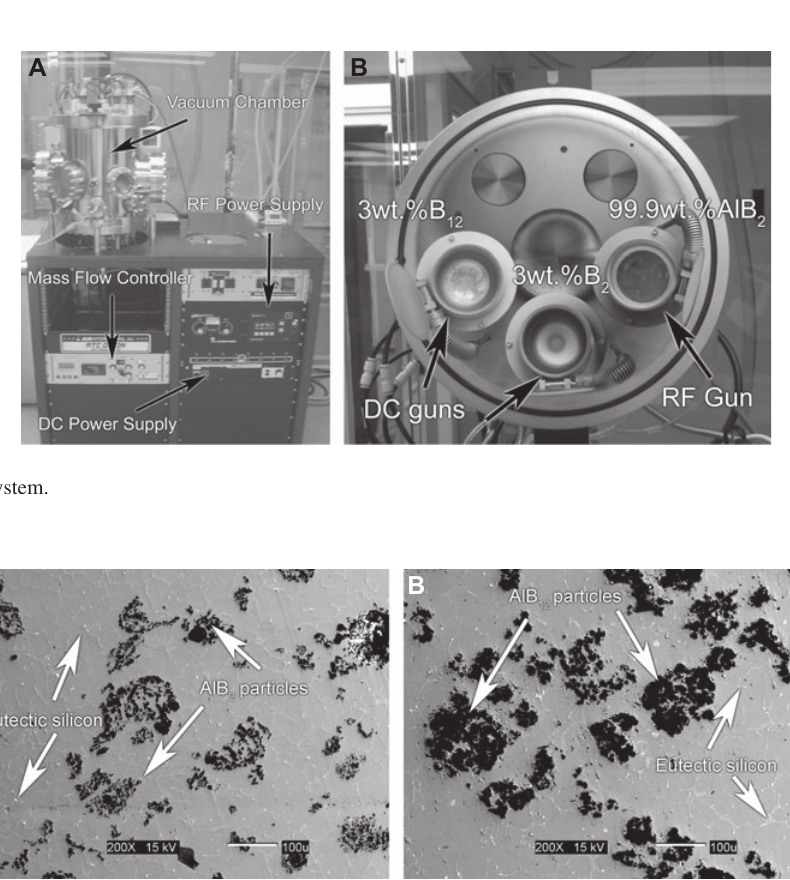
Figure 2 Backscattered electron SEM images of centrifuged targets containing (A) diboride and (B) dodecaboride